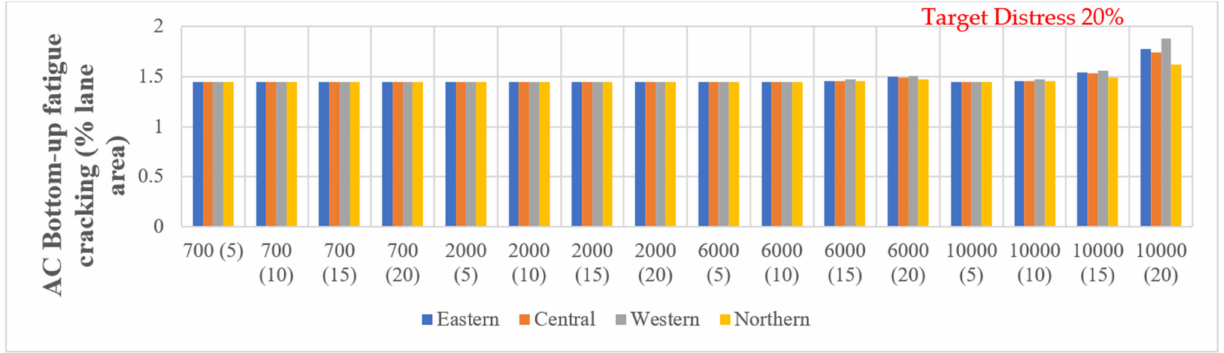
Figure 14. AC Bottom-up fatigue cracking (% lane area) for an interval of 5, 10, 15, and 20